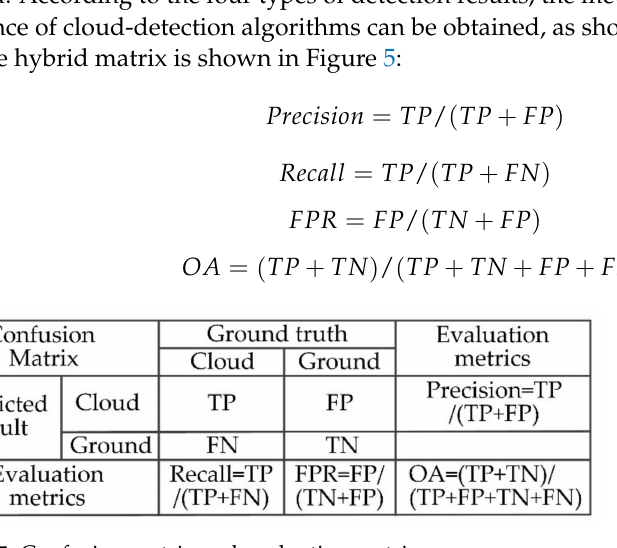
Figure 5. Confusion matrix and evaluation metrics.